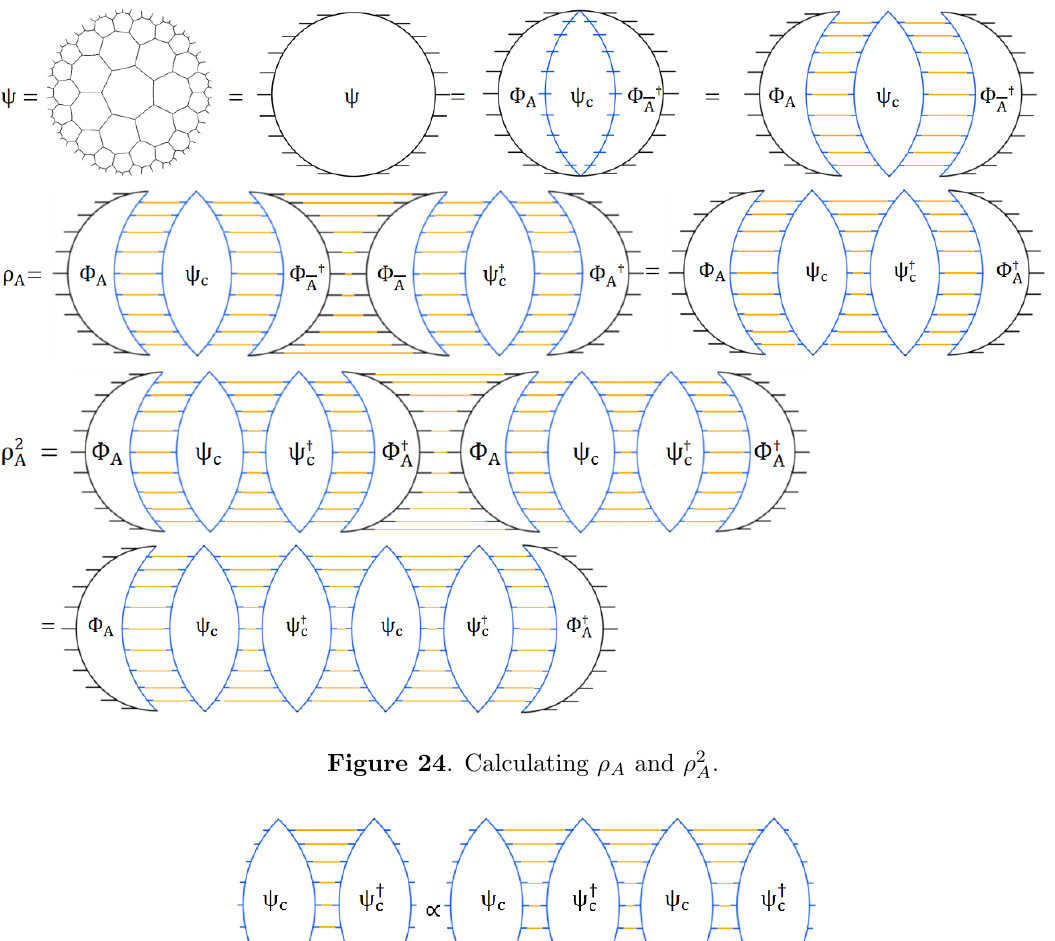
Figure 25 . The condition of (cid:13)at